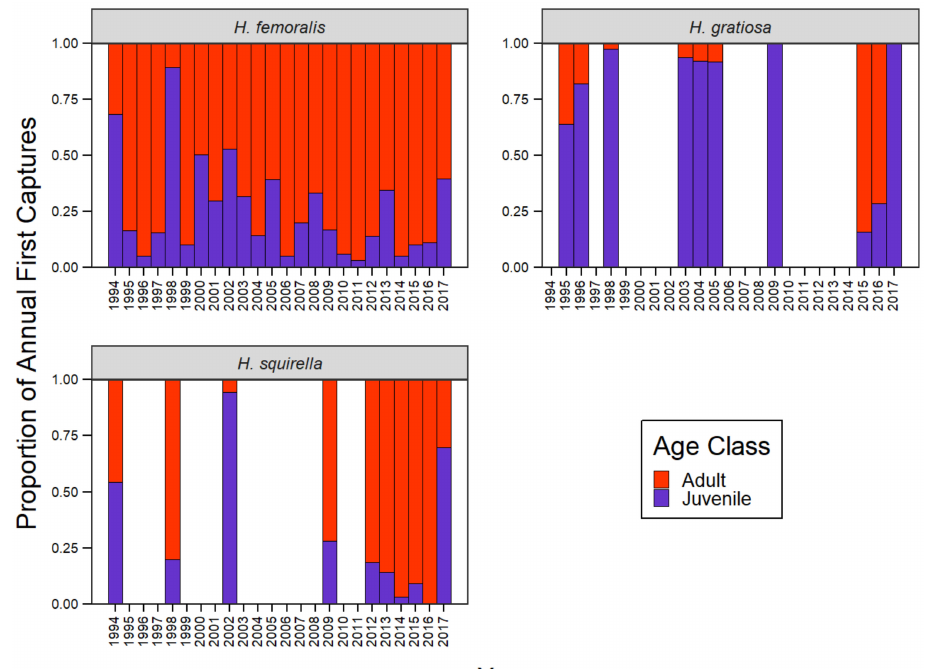
Figure 4. Proportions of annual adult (red) versus juvenile (blue) captures for each of our three study species in the period 1994–2017, Ocala National Forest, Marion County, Florida. Years with <5 total captures were excluded.